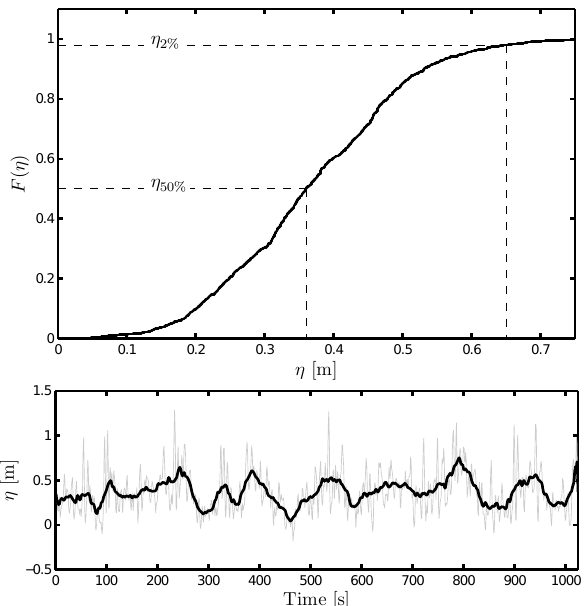
Fig. 6. Water level probability distribution at LPM1 for incident H s = 3.82m and T p = 14s. The probability distribution curve is calculated from the moving average (dark, solid line) of the instan- taneous free-surface elevation (light, thin line).